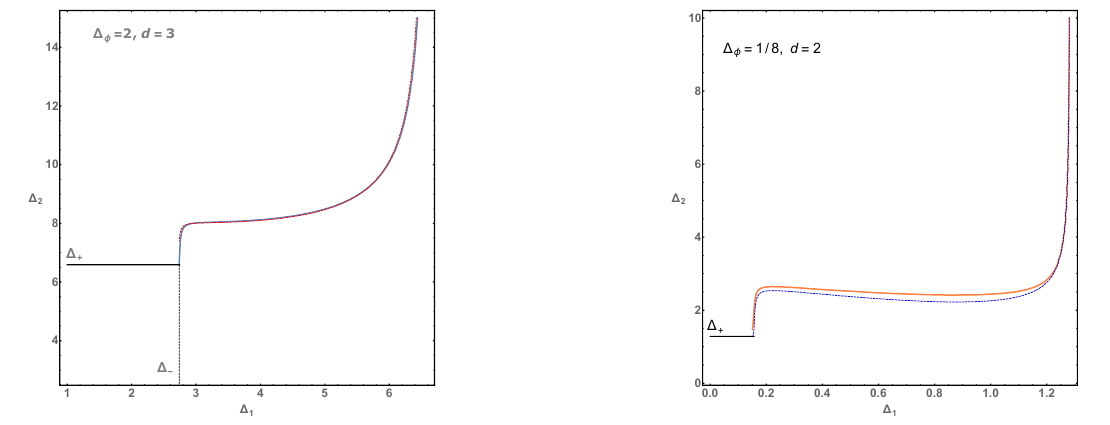
Figure 9. (a) Blue line is using exact scalar blocks and the red dashed line is using asymptotic scalar blocks. (b) Orange line is using spin-2 block for (cid:1) 2 and blue dashed line is using scalar block for (cid:1) 2